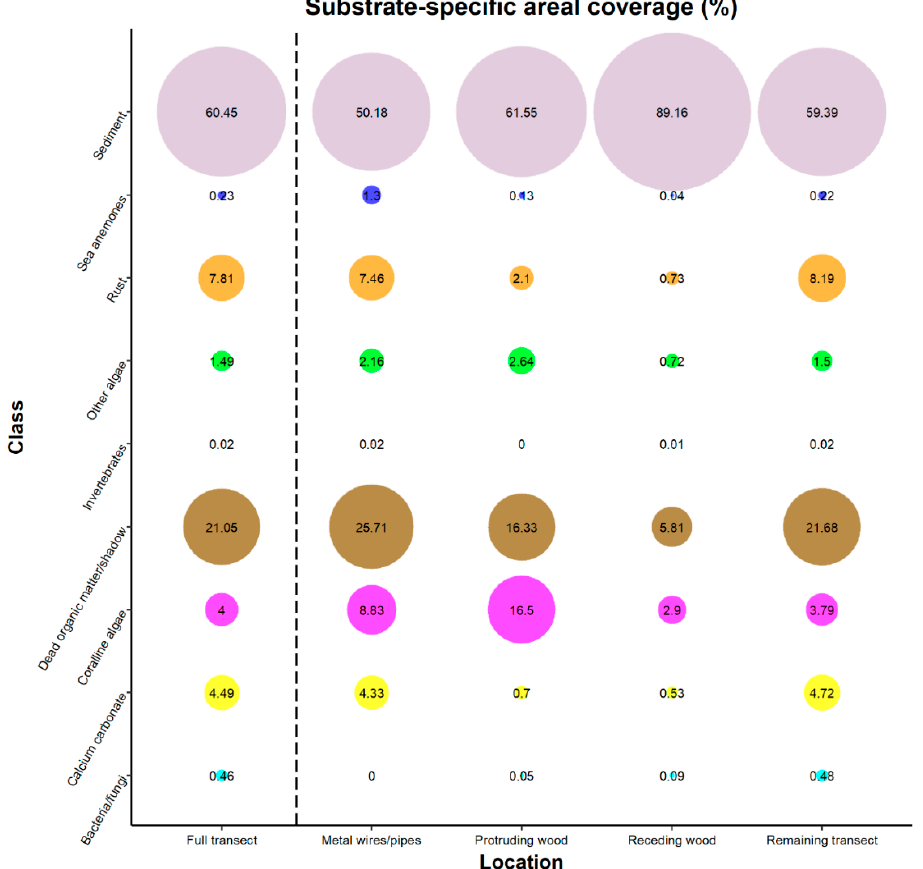
Figure 12. Estimated areal coverage (%) of nine spectral classes in the full underwater hyperspectral imaging (UHI) transect (full transect), and in four discrete subset areas of the UHI transect: metal wires/pipes, protruding wood, receding wood, and the remaining transect.